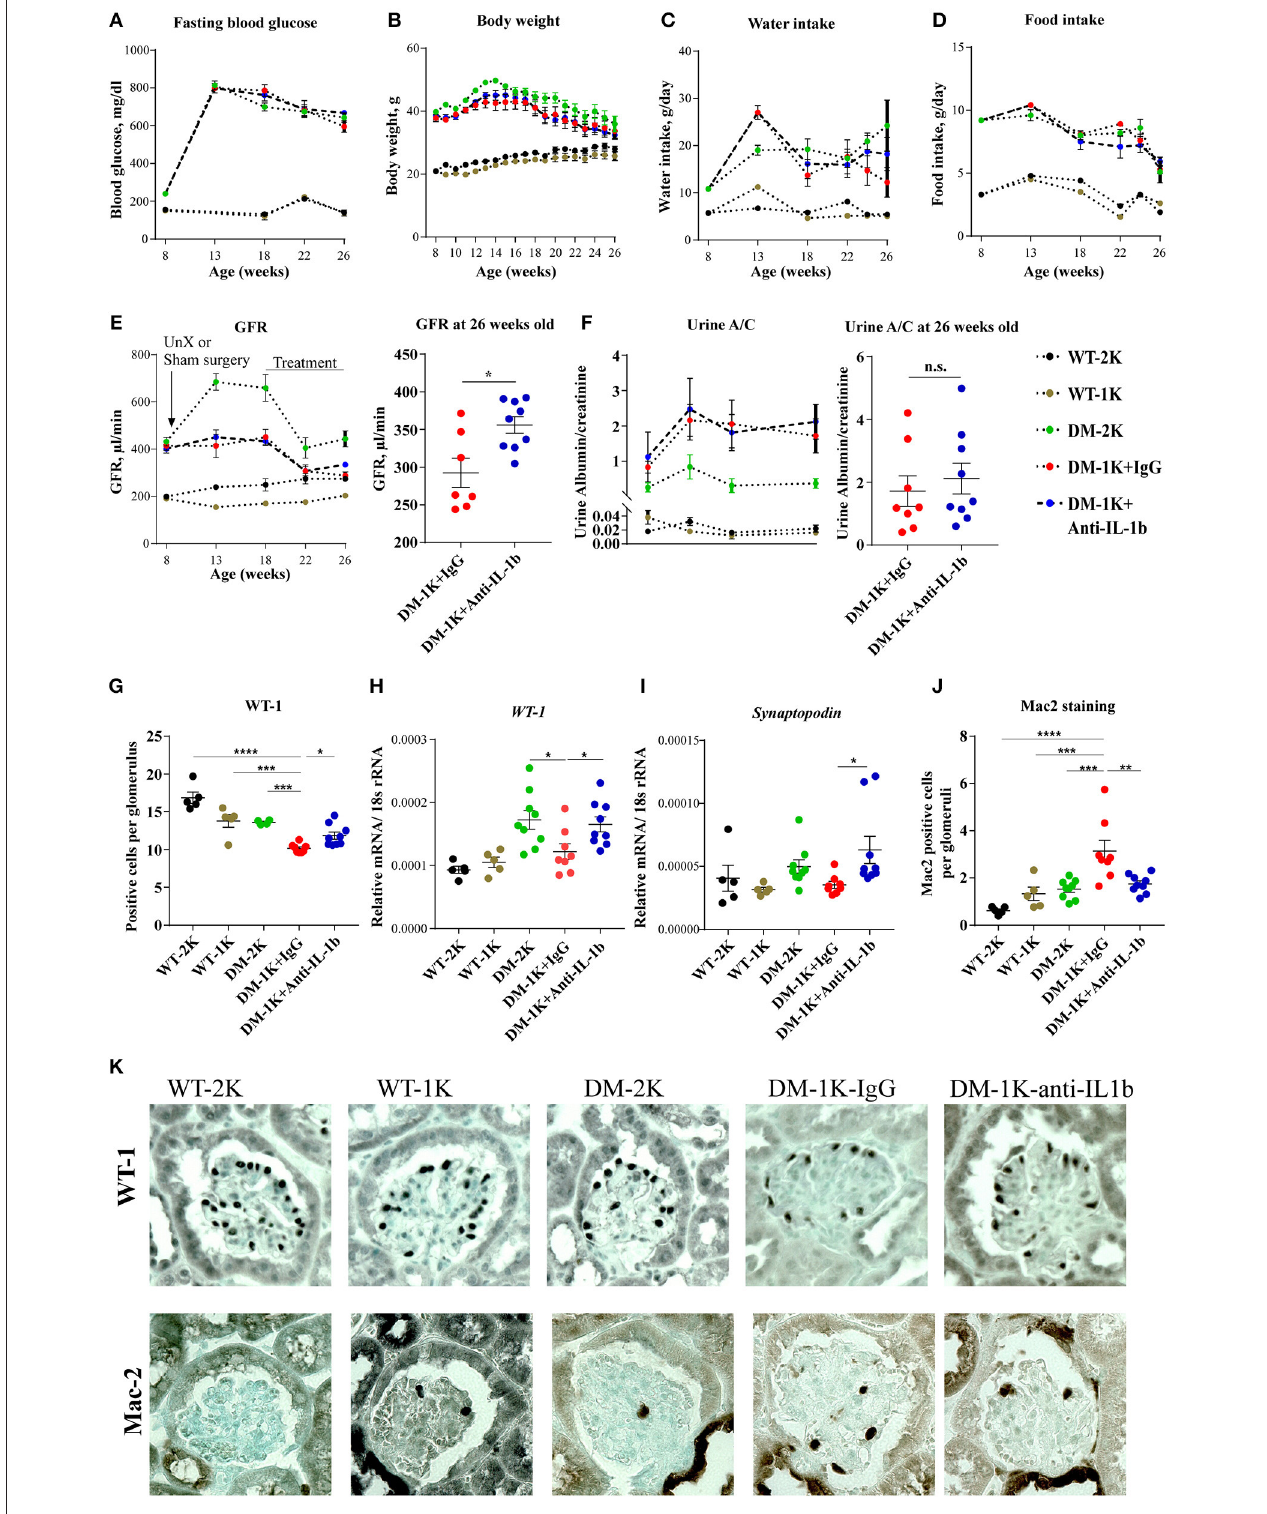
FIGURE 2 | Effects of anti-IL-1 β IgG on type 2 diabetic db/db mice. DM-1K mice were injected from week 18 to 26 of age with anti-IL-1 β antibody, which did not affect fasting blood glucose (A) , body weight (B) , water intake (C), or food intake (D) as compared to DM-1K with control IgG injection group. GFR (E) was